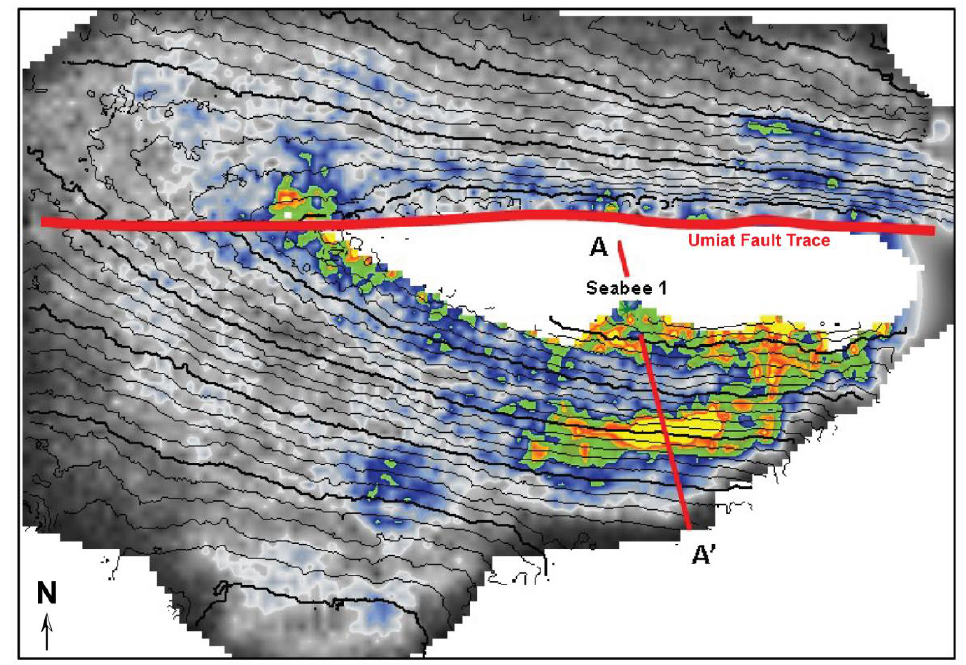
Figure 10. Time structure contours with AVO anomalies along the horizon, representing the top sand of LGST.